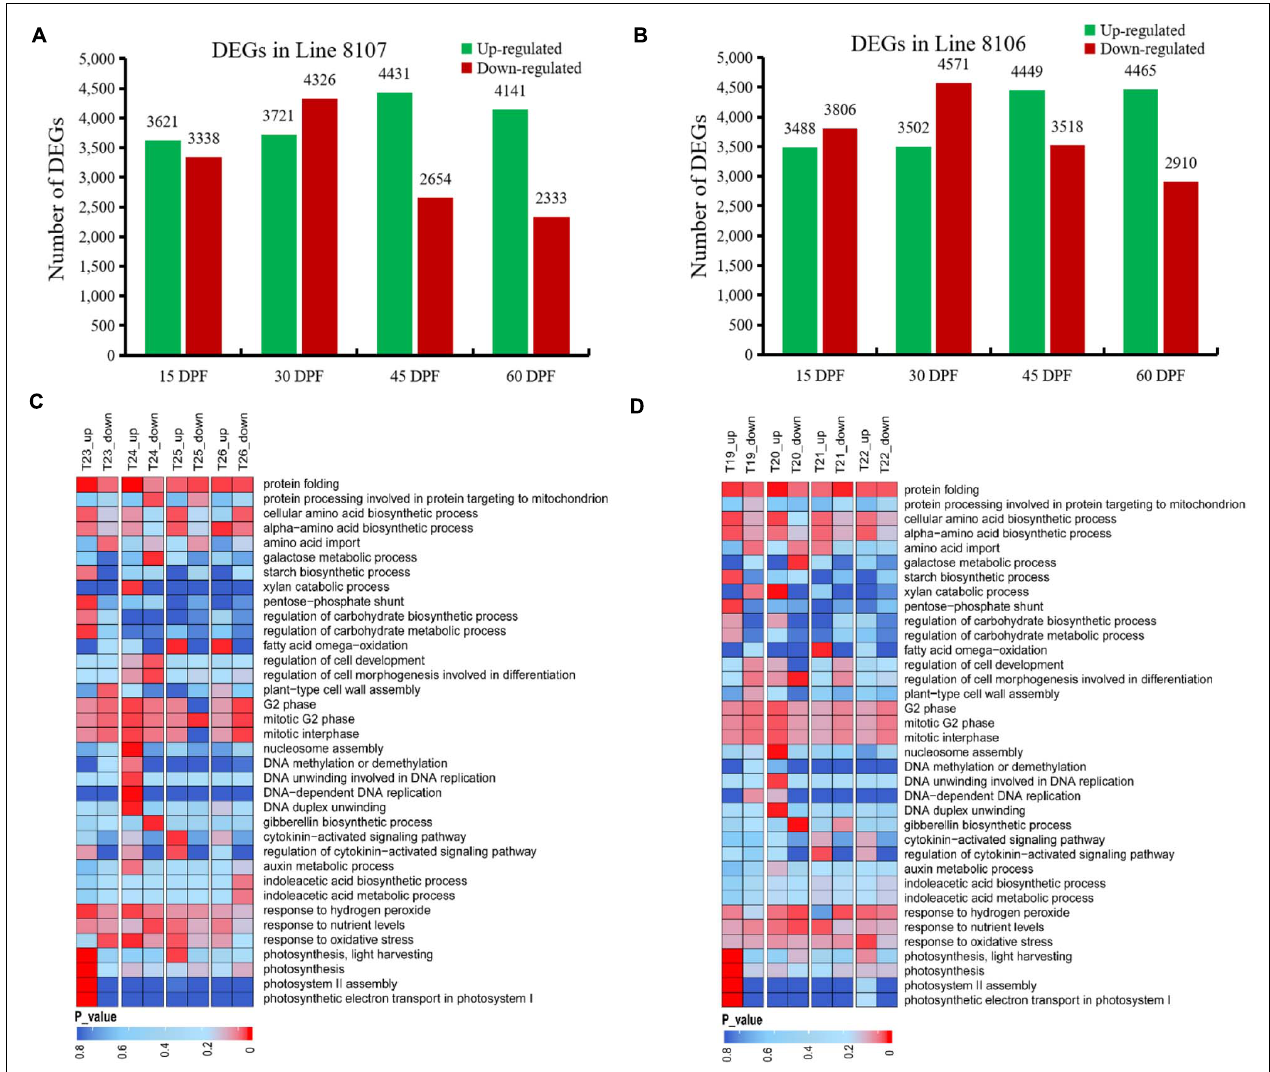
FIGURE 4 | DEGs between A. monticola and two cultivated peanut accessions at four seed developmental stages. Up-/down-regulated genes were detected in Line 8107 (A) and Line 8106 (B) at 15, 30, 45, and 60 DPF in pairwise comparisons with the wild peanut species A. monticola . Some GO terms were significantly enriched in the DEGs from Lines 8107 and 8106, and are shown in panels (C,D) , respectively. T19–T22, and T23–T26 indicate the seed samples at 15, 30, 45, and 60 DPF from Line 8106 and Line 8107,